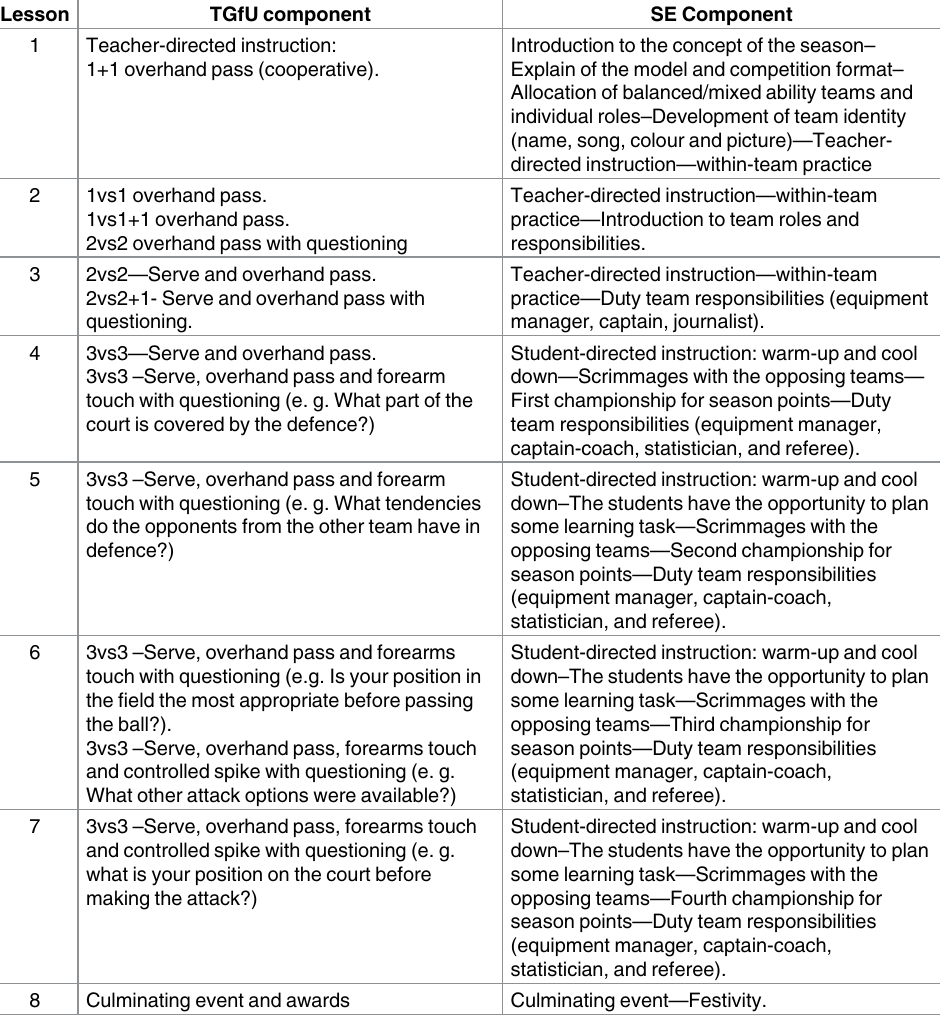
Table 1. Season plan for the hybrid unit, Sport Education–Teaching Games for Understanding.